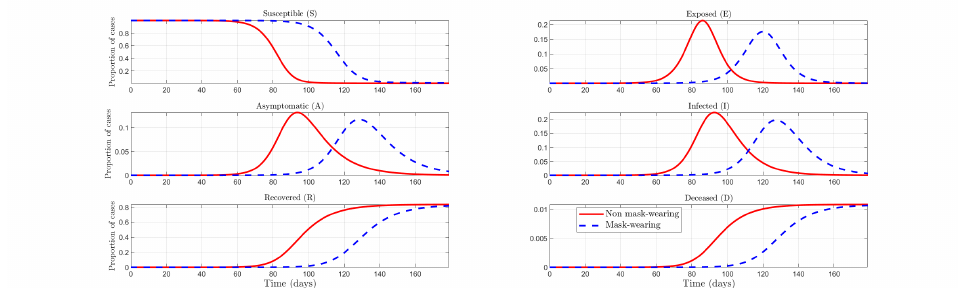
Figure 4. Mask wearing vs. non-mask-wearing culture comparison: the effect of social norms and efficient use of